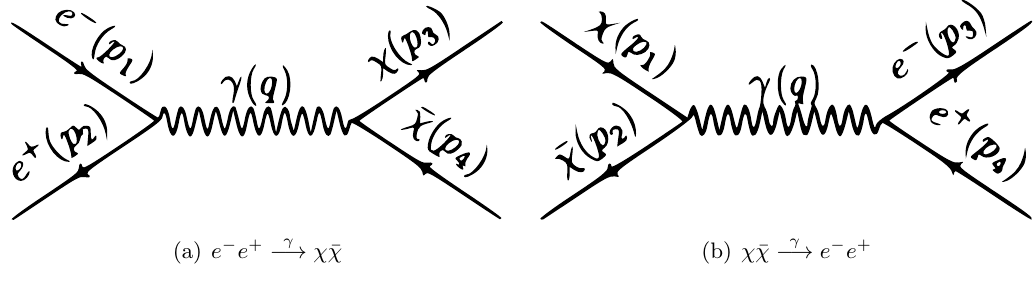
Figure 1 . Feynman diagram for the processes e (cid:0) e + (cid:13) (cid:0)! (cid:31) (cid:22) (cid:31) and (cid:31) (cid:22) (cid:31) (cid:13) (cid:0)! e (cid:0) e +